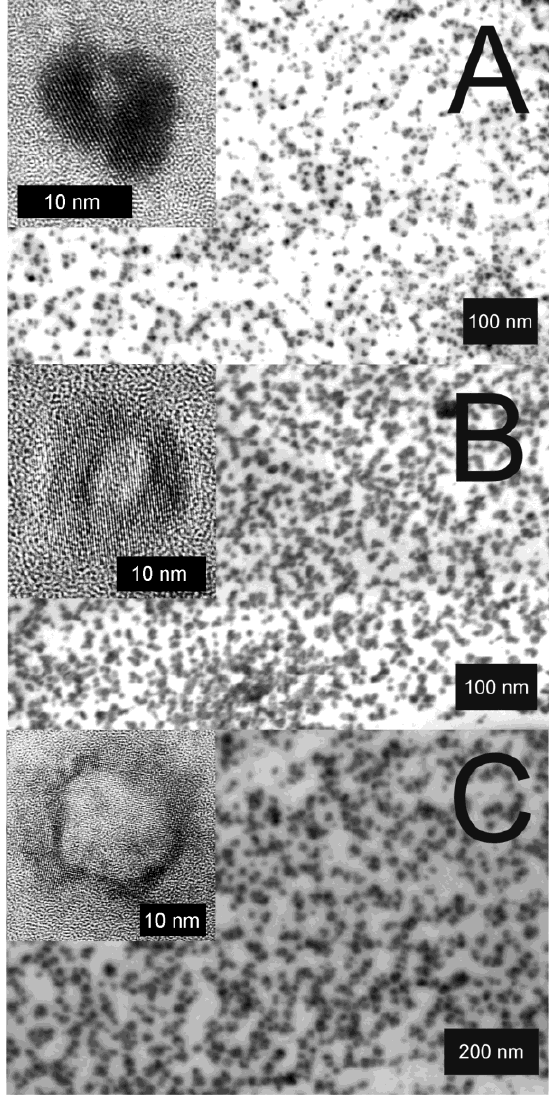
Figure 7. STEM and HRTEM images of La(OH) w/o -microemulsions with different volumes of the water-phase and different amounts of dissolved KF: A) 1 mL of 0.2 M KF; B) 1 mL of 0.1 M KF; C) 2 mL of 0.1 M KF (reproduction from